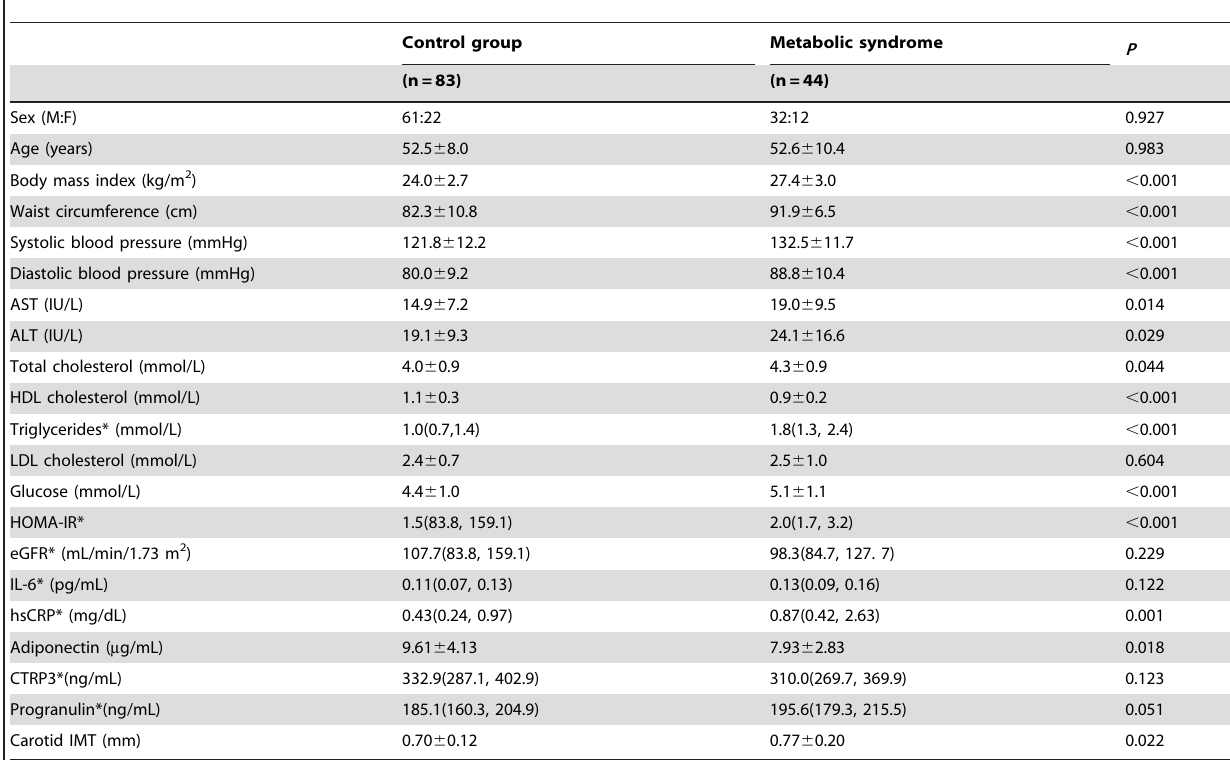
Table 1. Baseline Characteristics of the Study